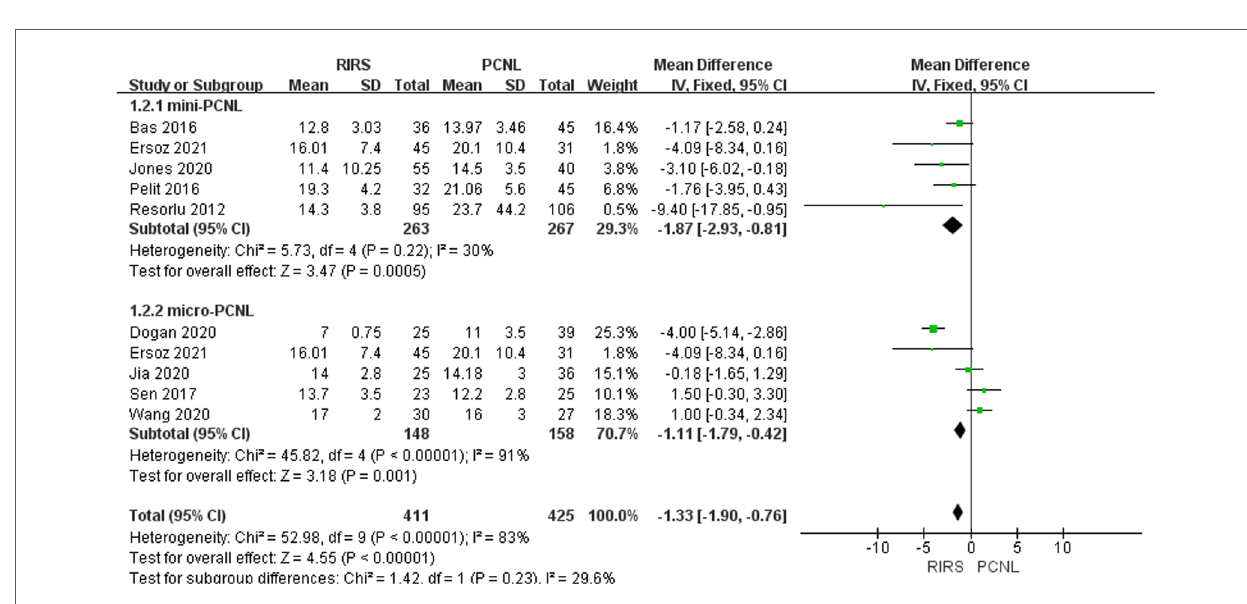
FIGURE 5 Forest plot of stone size between the RIRS group and the PCNL